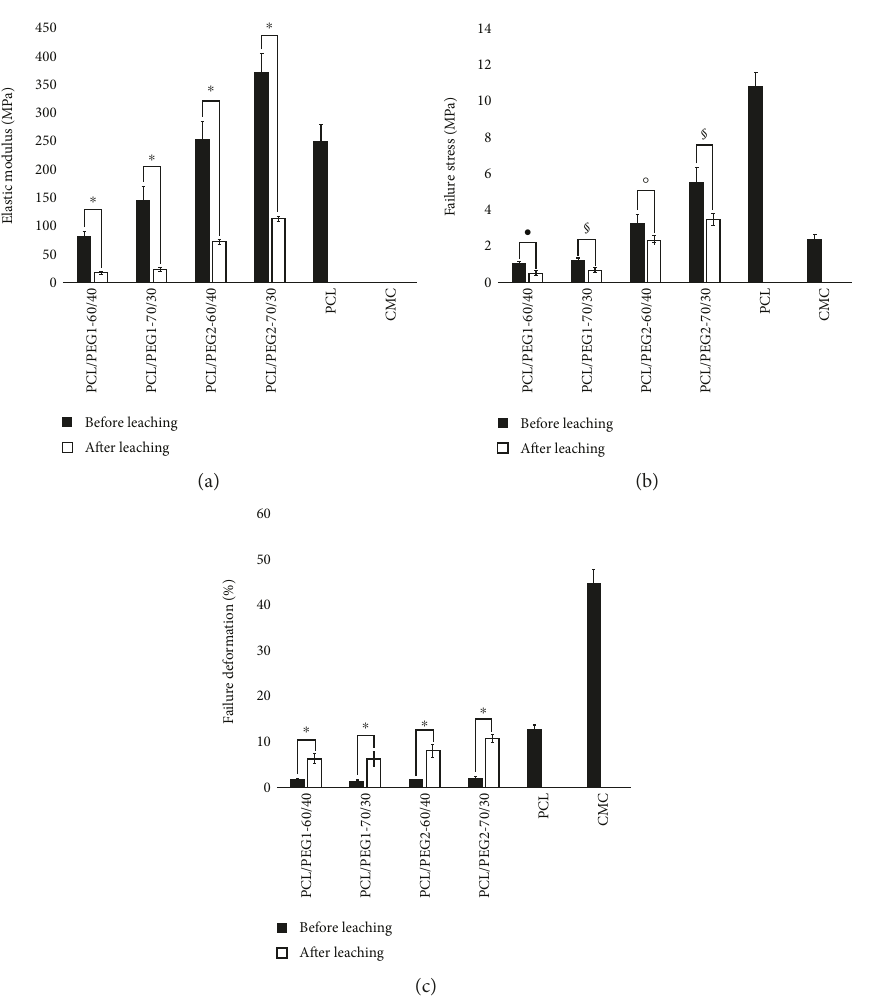
Figure 3: Comparative analysis of elastic modulus (a), failure stress (b), and failure deformation (c) for PCL/PEG blends before and after leaching. ∗ p < 0 0001 , (cid:129) p = 0 0002 , § p = 0 0008 , and ⚬ p = 0 0086